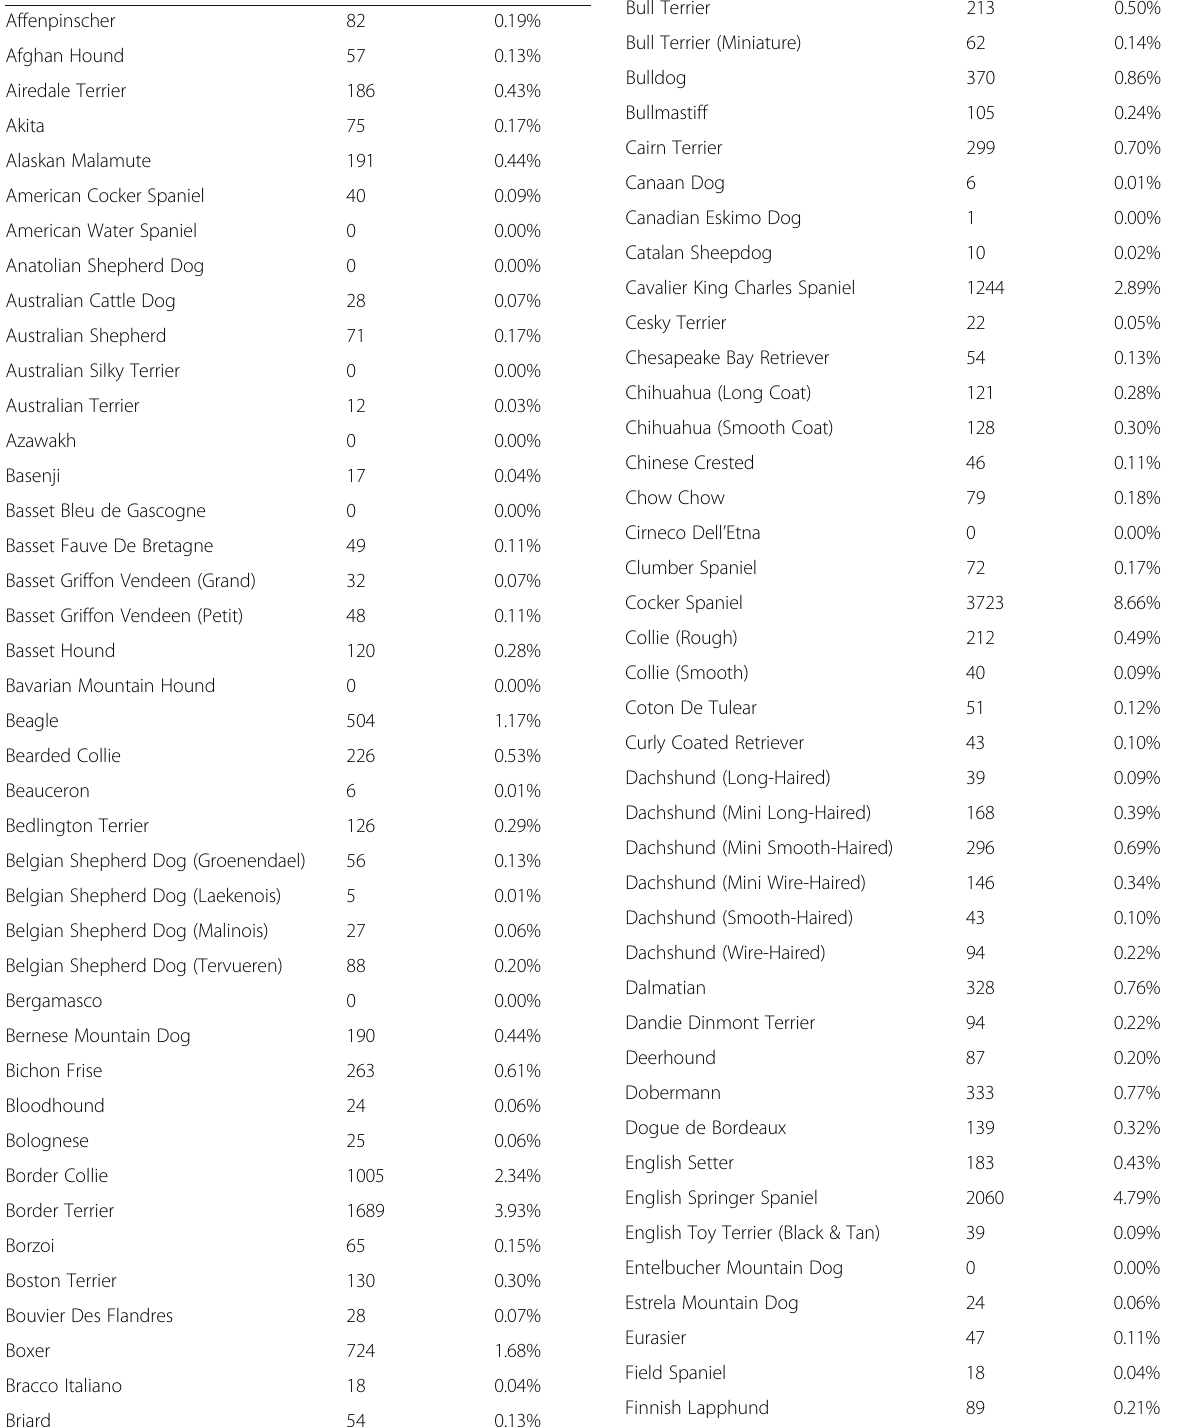
Table 1 Number of unique individual dogs for which responses were received and approximated response rate (from total number registered from 2004 – 13 inclusive) for all breeds